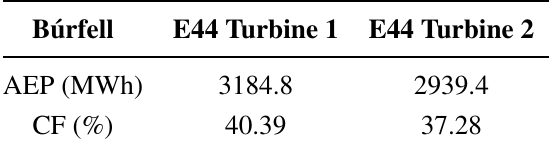
Table 7. Measured annual energy production (AEP) and capacity factor (CF) for both E44 900-kW wind turbines at